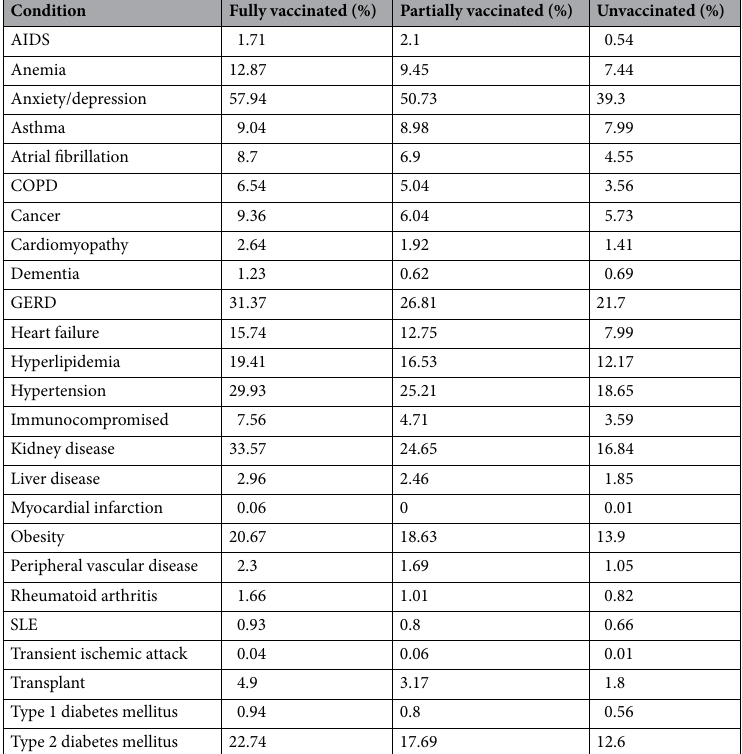
Table 8. Comorbidity information of patients with a positive SARS-CoV-2 result during the Omicron variant wave (n = 29,054 SARS-CoV-2 infections) expressed as frequency percentage.